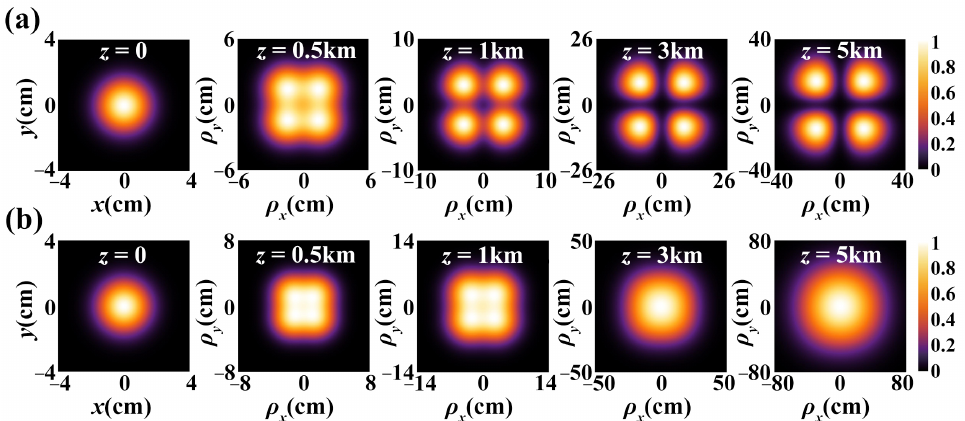
Figure 2. Development of the normalized spectral intensity of an SSS beam traversing through ( a ) free space and ( b ) oceanic